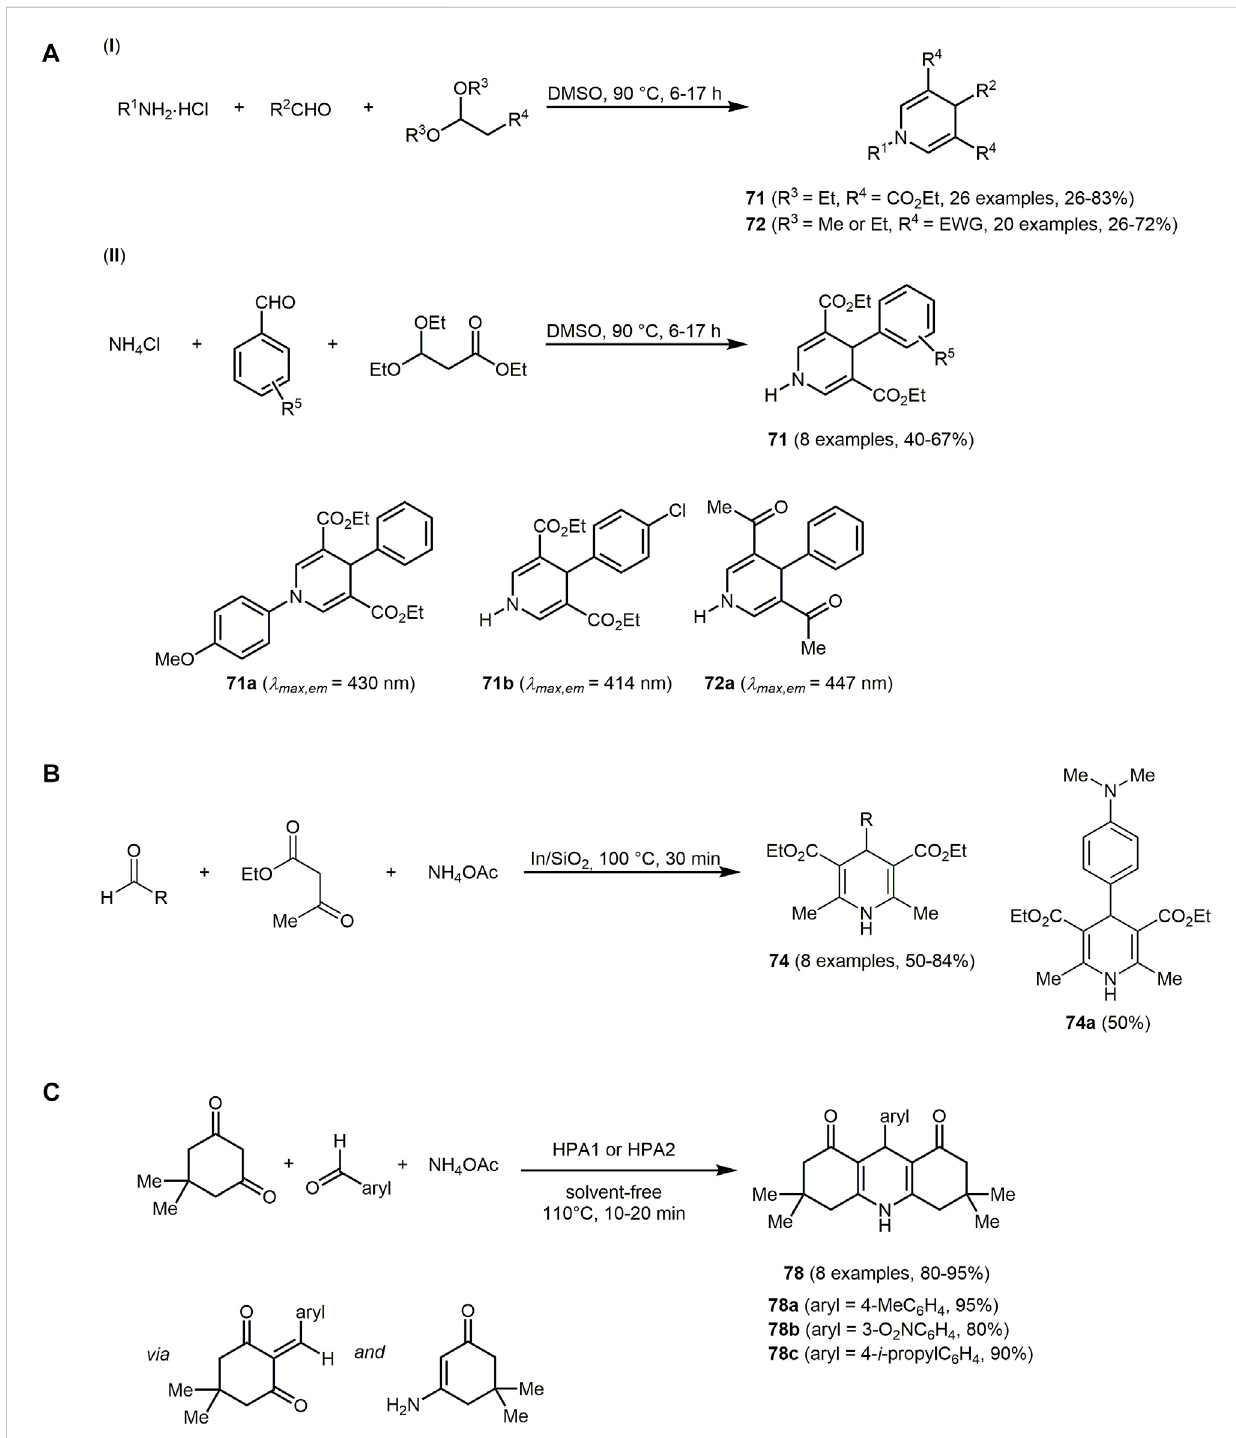
The emission spectra of 78c recorded in different solvents and at different temperatures exhibit a maximum at around 520 nm under all conditions.